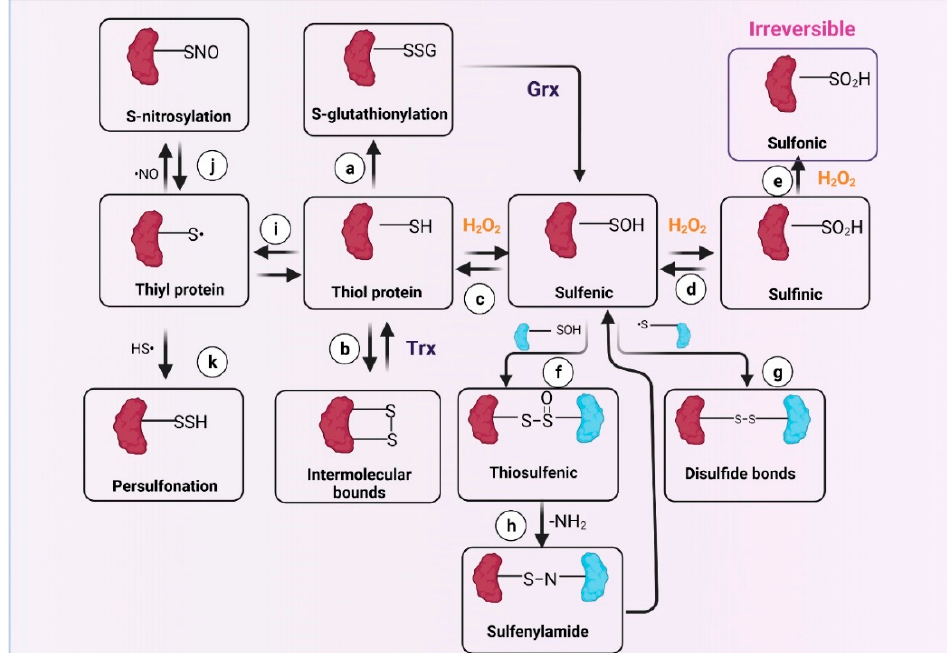
Figure 4. Reactive oxygen species (ROS) induce post-translational modifications in cysteine (Cys) residues that participate in redox signaling. ROS oxidize Cys residues containing thiol groups, forming ( a ) S-glutathionylation (R–SSG), reversed by glutaredoxin (Grx) enzymes. Thiols also can form ( b ) intermolecular bonds, modification reversed by thioredoxin (Trx) system; however, ROS can prompt ( c ) sulfenic form (R–SOH) by suffering oxidation with hydrogen peroxide (H 2 O 2 ). If oxidated by H 2 O 2 , R-SOH can give place to ( d ) sulfinic (R–SO 2 H) or ( e ) sulfonic form (R–SO 3 H); the latter is irreversible. Additionally, the oxidation of R–SOH might form ( f ) thiosulfenic [R–S(O)–S-R’] by interacting with another protein containing R-SOH modification or with a protein that contains a thiol group (R–S • ) to form ( g ) disulfide bonds (R–S–S–R’). R–S(O)–S-R’ might interact with amide (–NH 2 ) groups, forming ( h ) sulfenylamide (R–SN–R (cid:48) ), which can be reversed to R–SOH form.